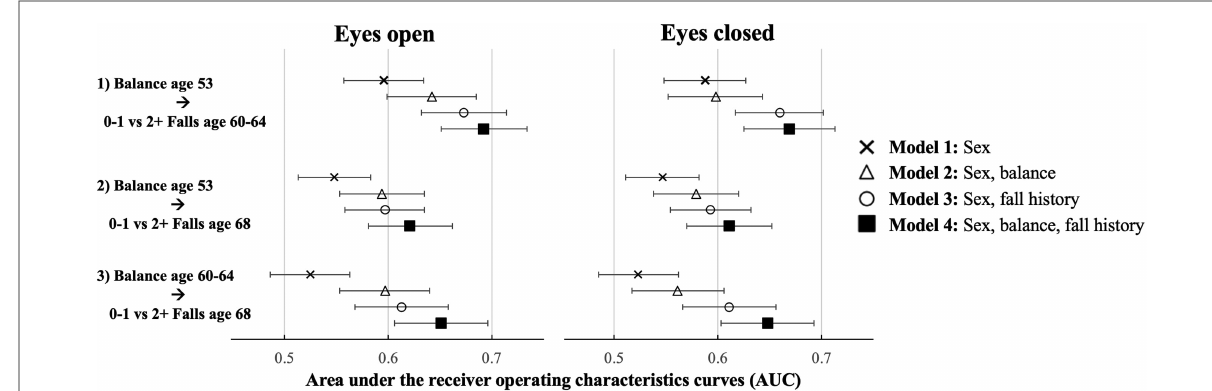
FIGURE 1 Prognostic accuracy of the one-legged balance test and recurrent falls: comparison of a sex-only model (1); with a balance and sex-adjusted model (2), a sex and past falls model (3) and a sex, balance and past falls model (4) using area under receiver operating characteristics curves (AUC) with eyes open and eyes closed. Note each plotted point refers to a distinct model (32 total).